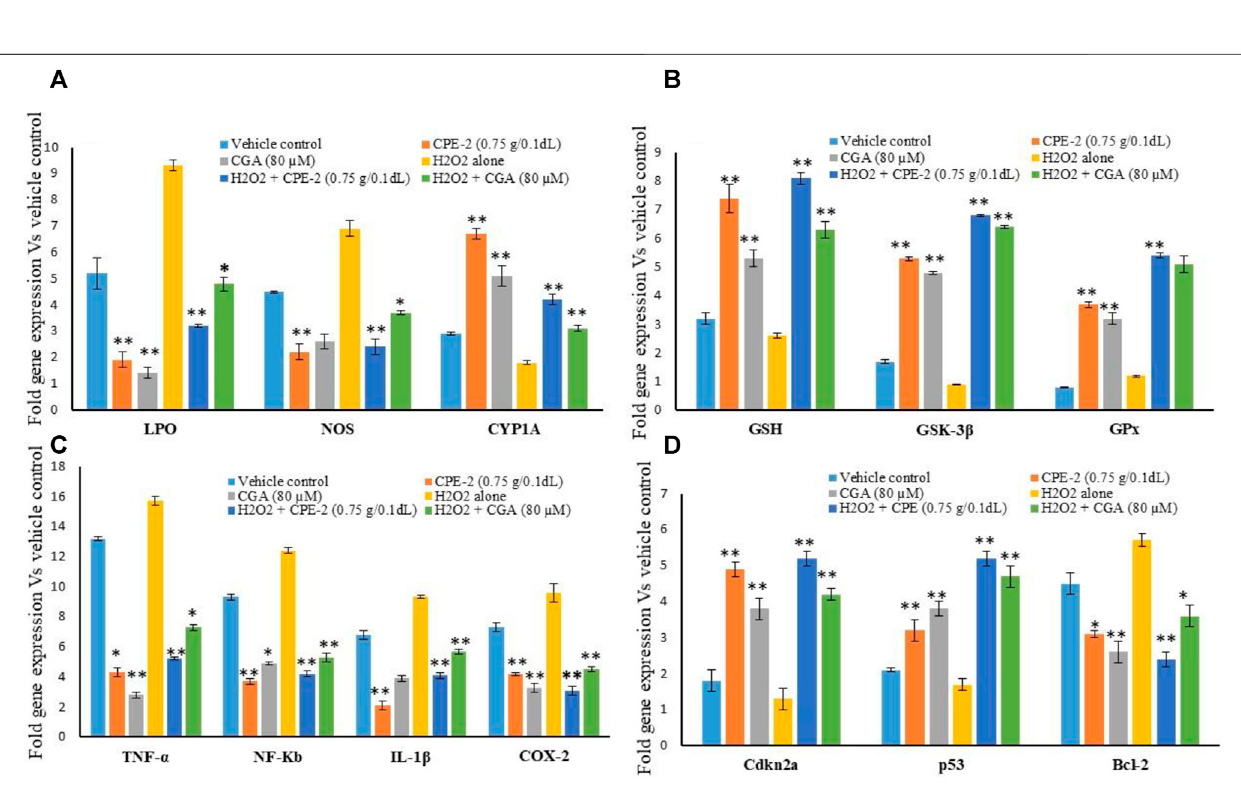
FIGURE 7 | Effect of vehicle control and CPEs (CPE-2; 0.75 g/0.1 dl) on oxidative stress (A) , antioxidant (B) , pro-in fl ammatory (C), and tumor suppression (D) related gene expression levels after 48 h. Each of the values are mean ± SD ( n (cid:1) 6). * p ≤ 0.05 and ** p ≤ 0.001 were compared with vehicle control or H 2 O 2 alone treated